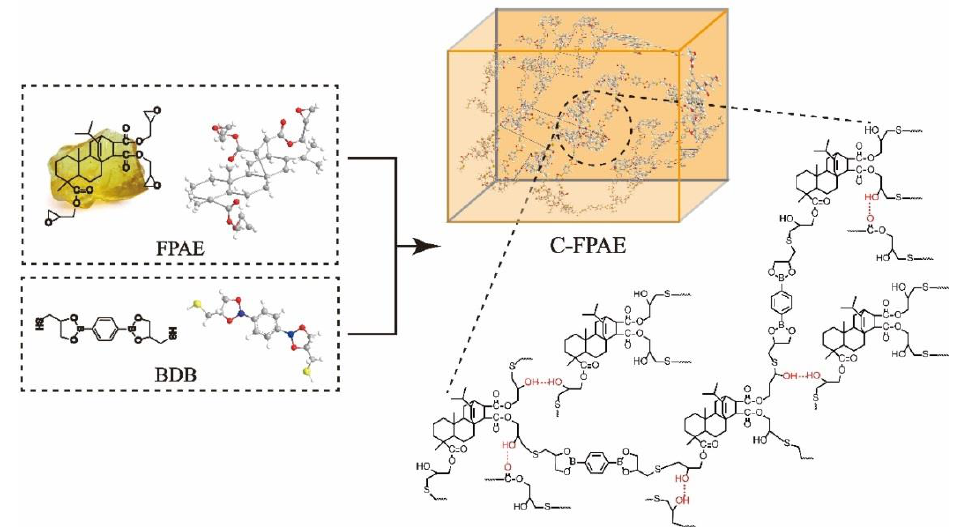
Figure 1. Synthesis of a C-FPAE cross-linking